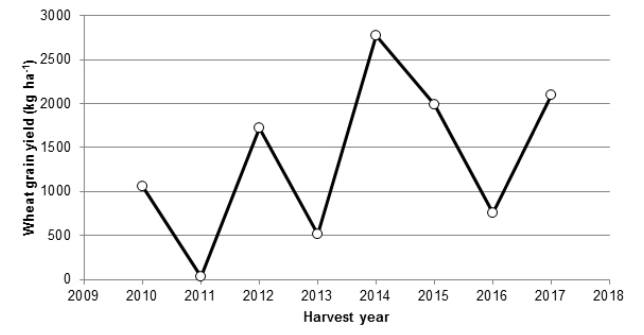
Figure 1. Wheat yield on the farm, 2010-2017 (kg per ha). A linear regression of grain yield on year was not significant (Adjusted R 2 = 0.06, df =